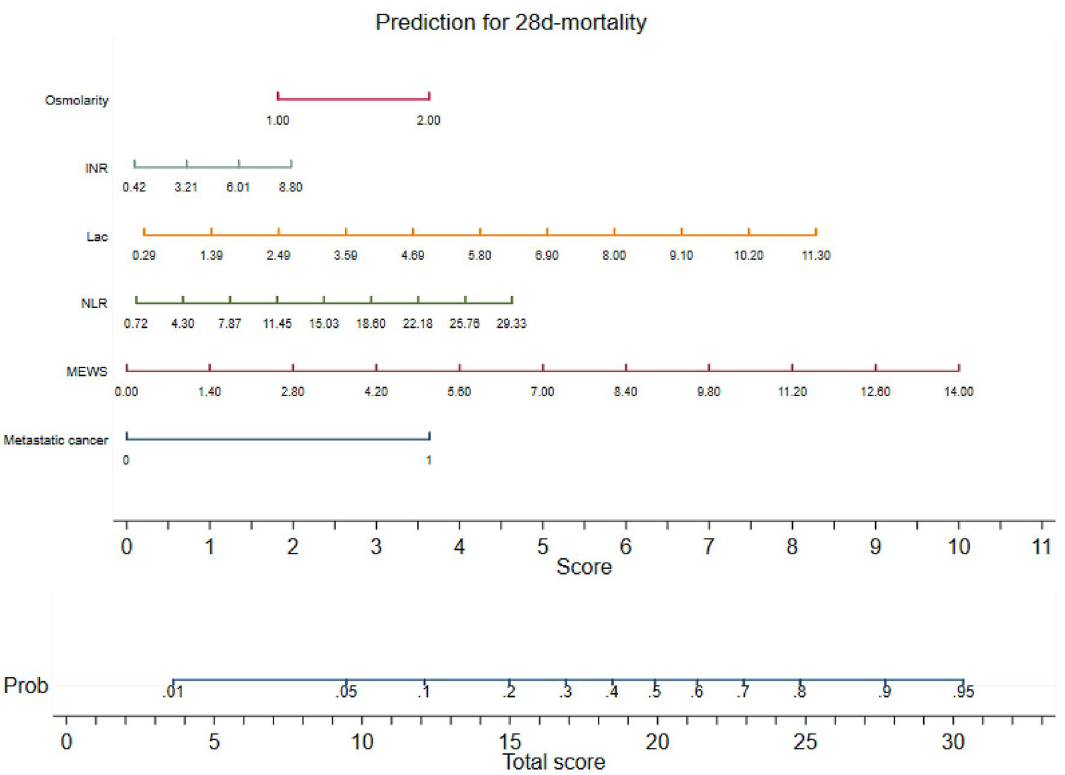
Figure 9. Nomogram for the mionl-MEWS model. On the nomogram, an individual patient’s predicted mortality risk according to the mionl-MEWS model is located on each variable axis, and a line is drawn upward to determine the corresponding score for each variable state. The sum of these numbers indicates the total score, and a line is drawn to the probability axis to determine the likelihood of 28-day mortality ( INR international normalized ratio, Lac lactate, MEWS Modified Early Warning Score, NLR neutrophil-to-lymphocyte